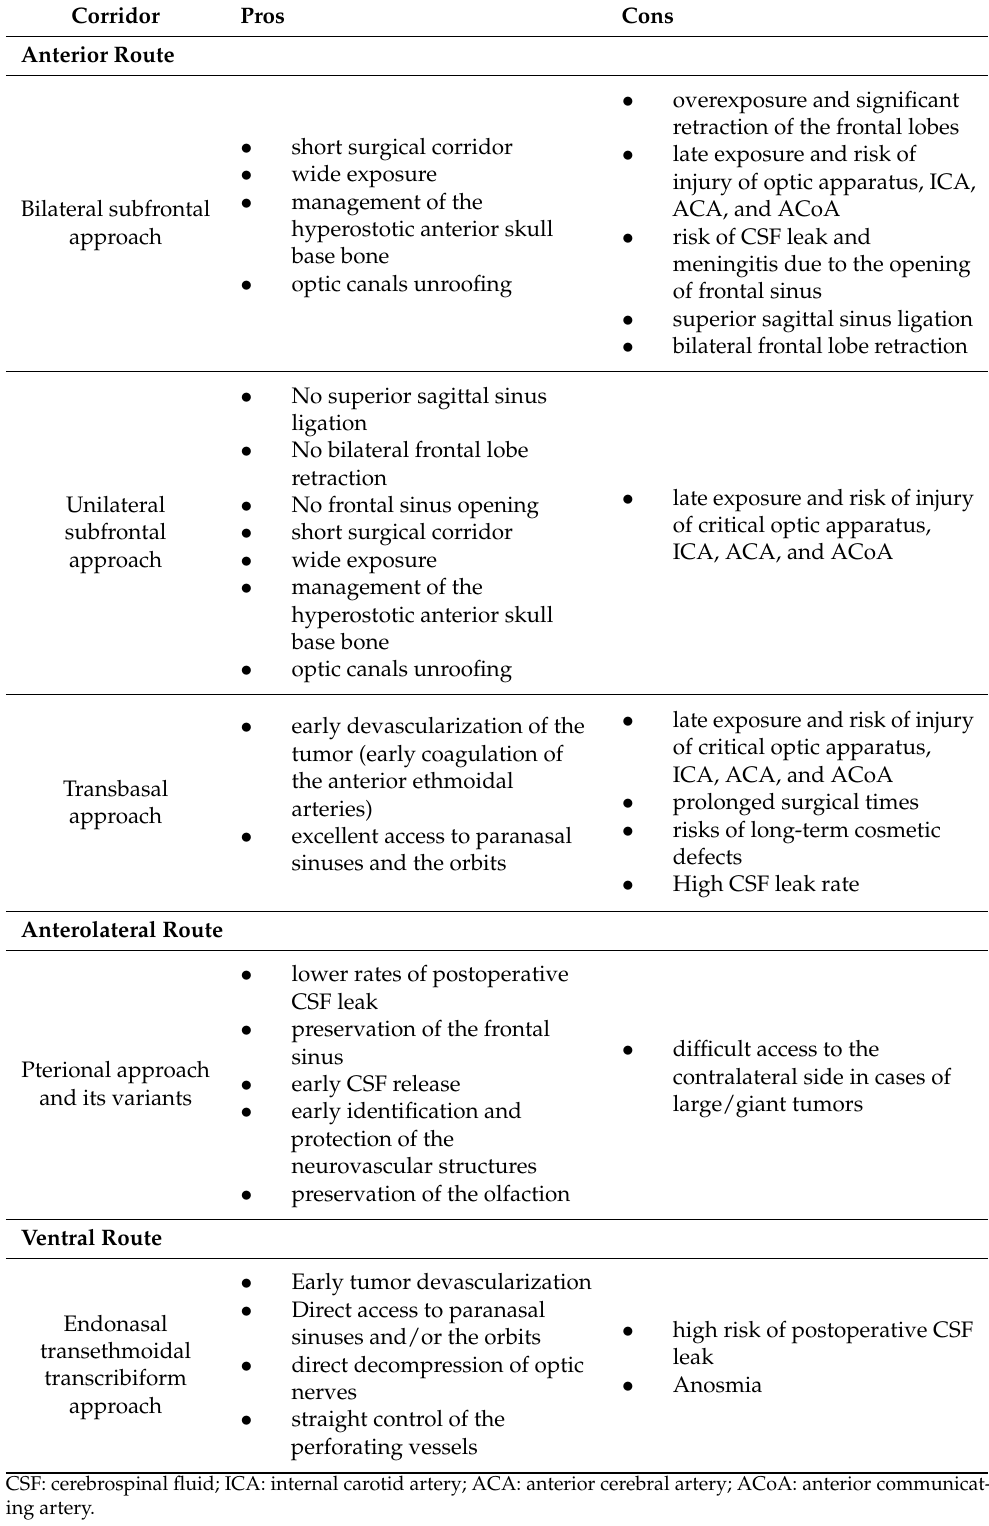
Table 2. Pros and cons for each corridor for the management of olfactory groove meningiomas